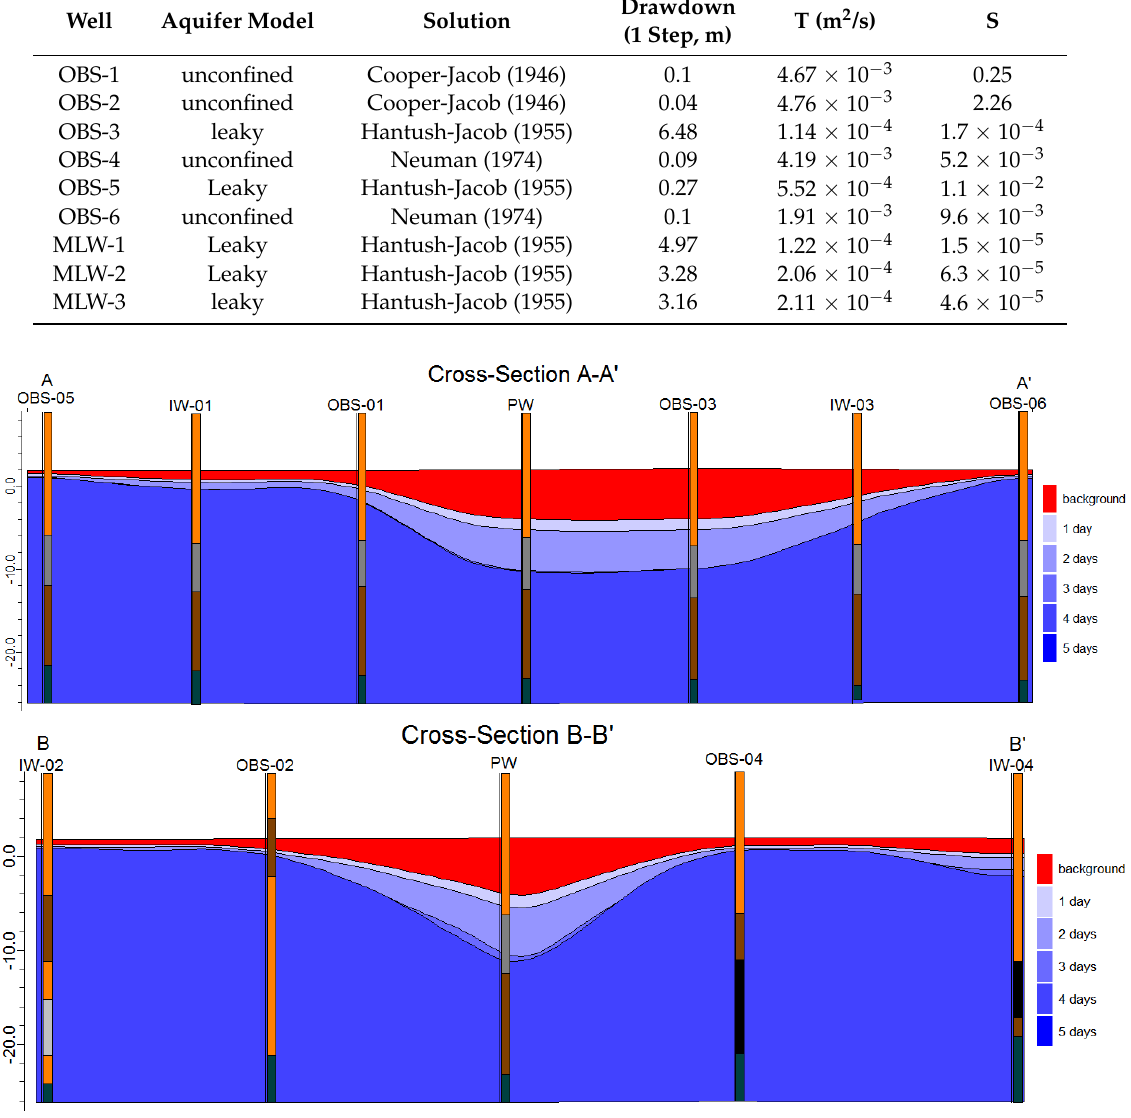
Table 2. Hydraulic parameters at the observation wells using pumping test solutions.